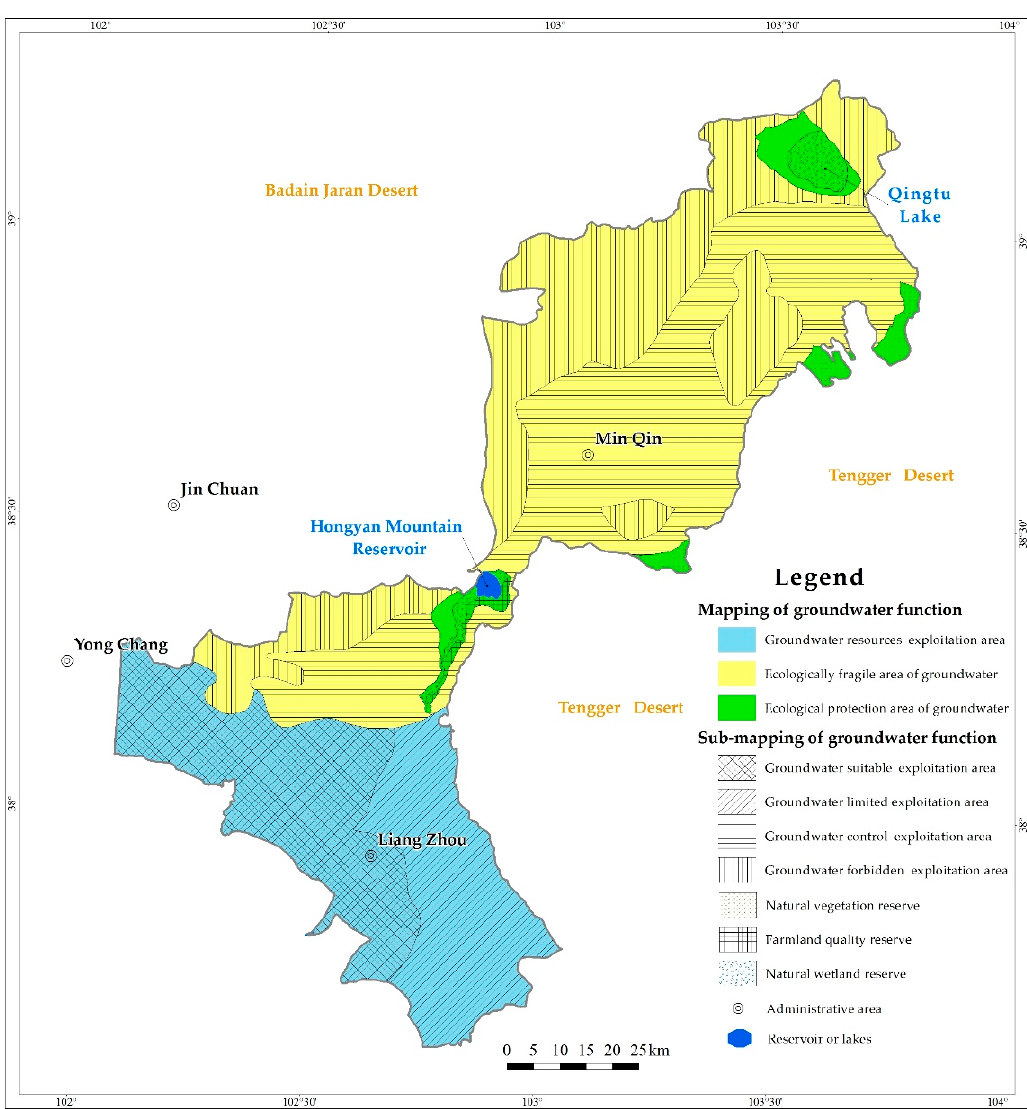
Figure 2. Mapping of groundwater function in Shiyang River basin.